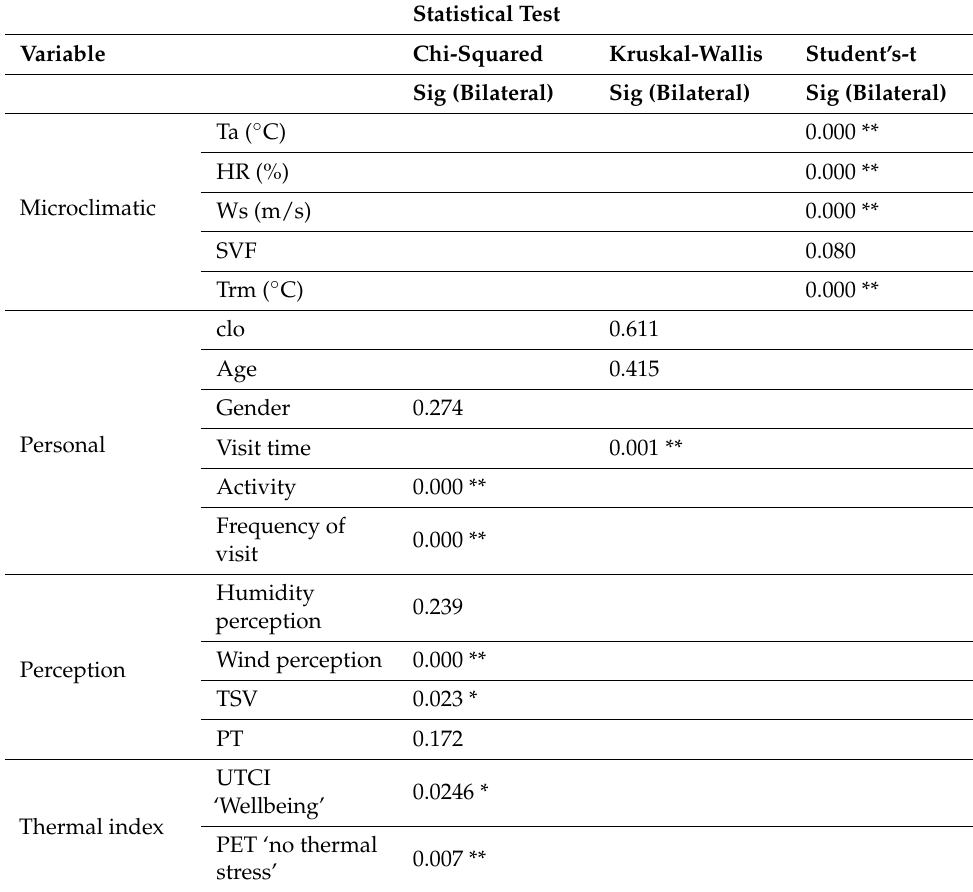
Table 3. Statistical differences between Madrid climate (Csa) and Newcastle upon Tyne climate (Cfb). Statistical Test